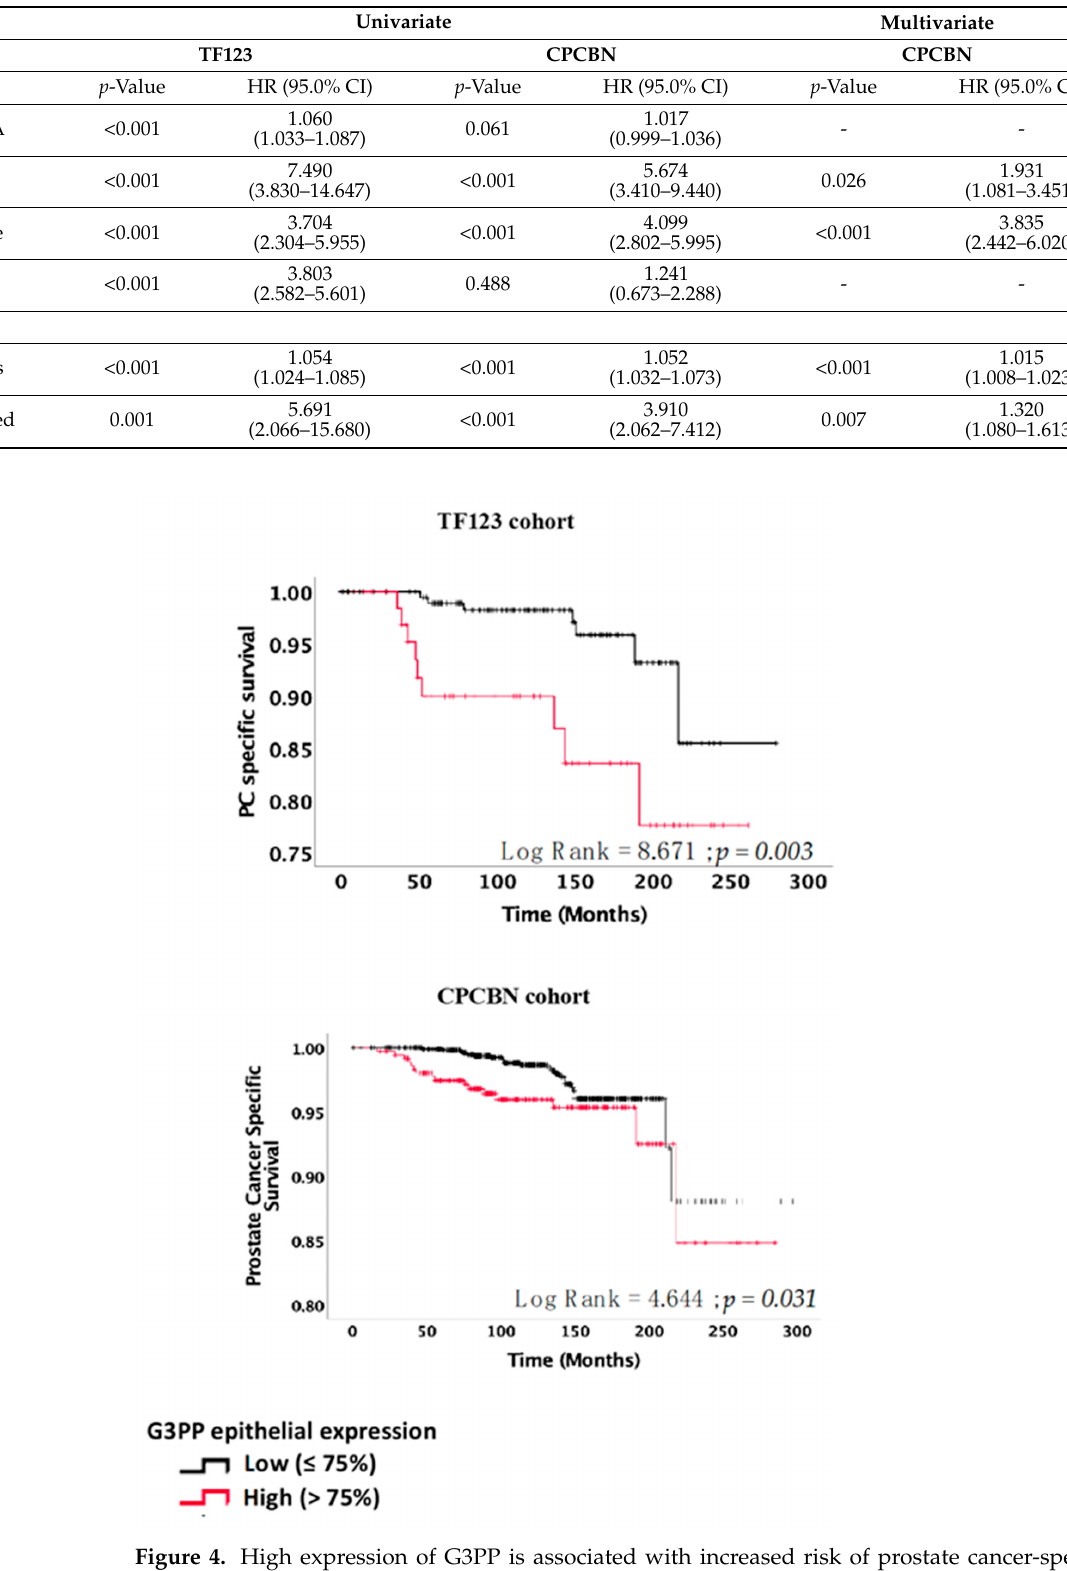
Figure 4. High expression of G3PP is associated with increased risk of prostate cancer-specific mortality. Kaplan–Meier bone metastasis-free survival curves after overall follow-up for the TF123 and CPCBN cohorts.